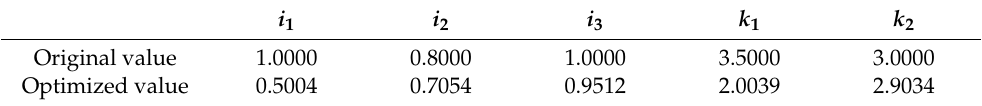
Table 2. Parameter values of N-DMCDS before and after